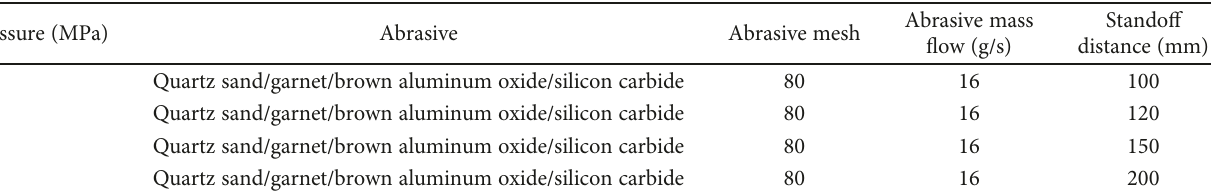
Figure 2: Nozzle structure parameters. Table 1: Experimental